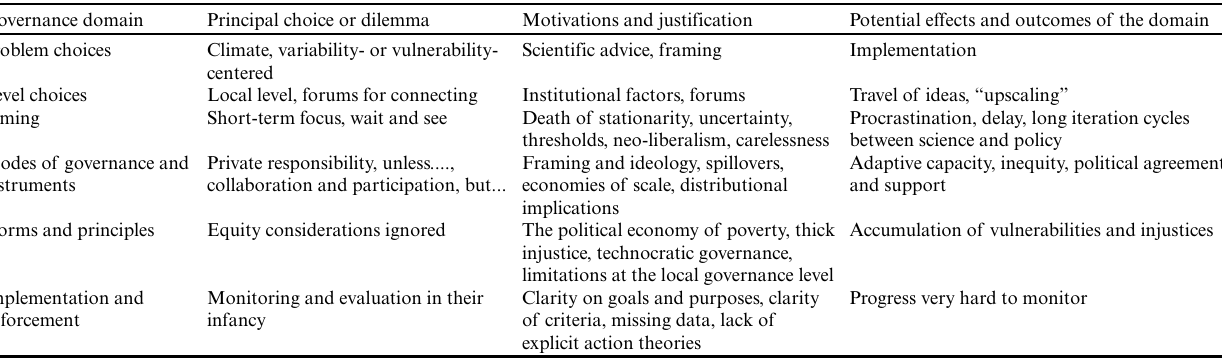
Table 2 . Domains of design and choice in adaptation governance and their focus, motivation, and potential